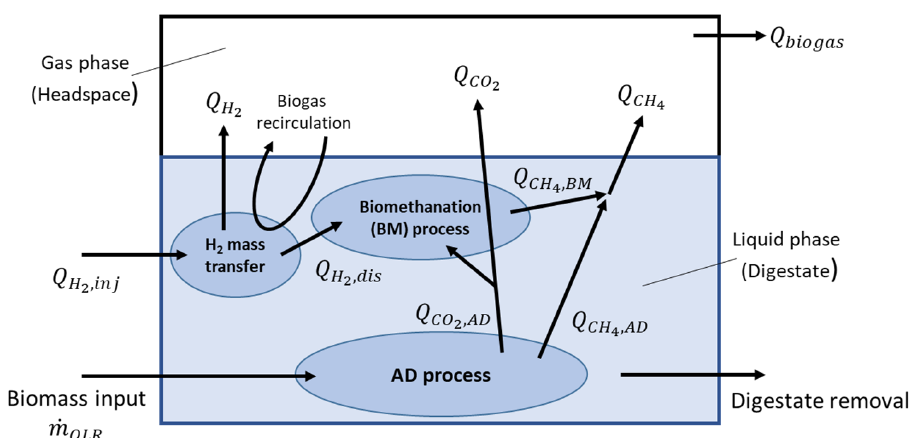
Figure 3. Overview of the mathematical model of the in-situ biomethanation process .